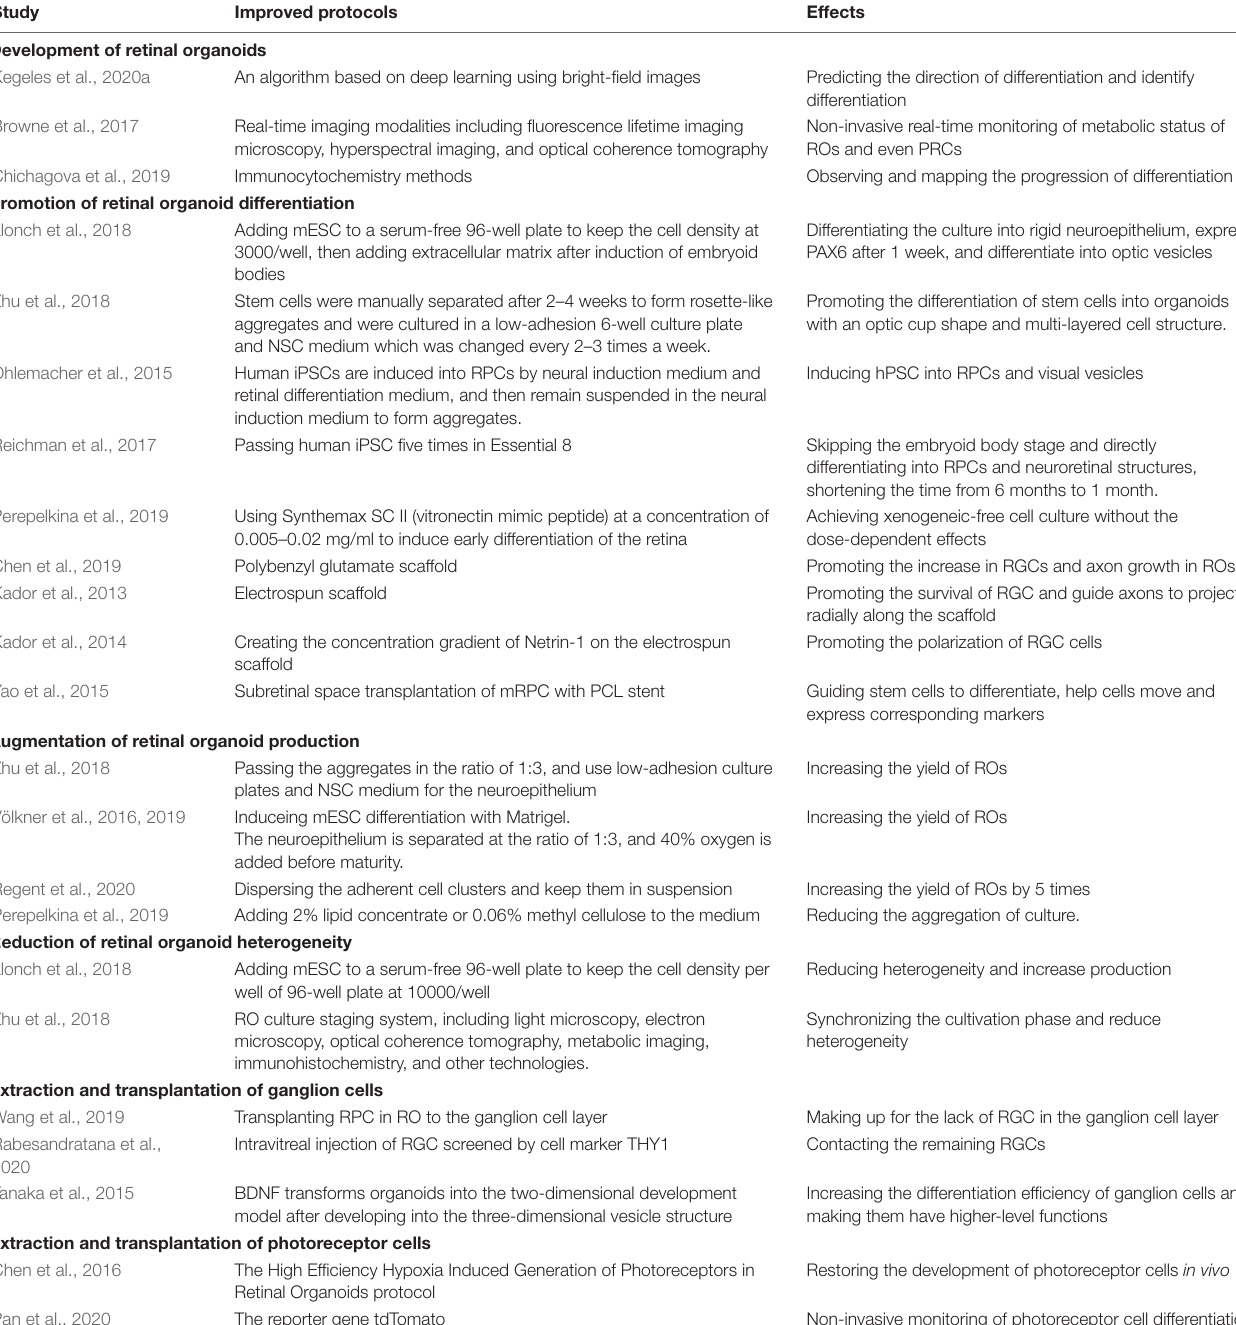
TABLE 1 | Summary of improved protocols of retinal